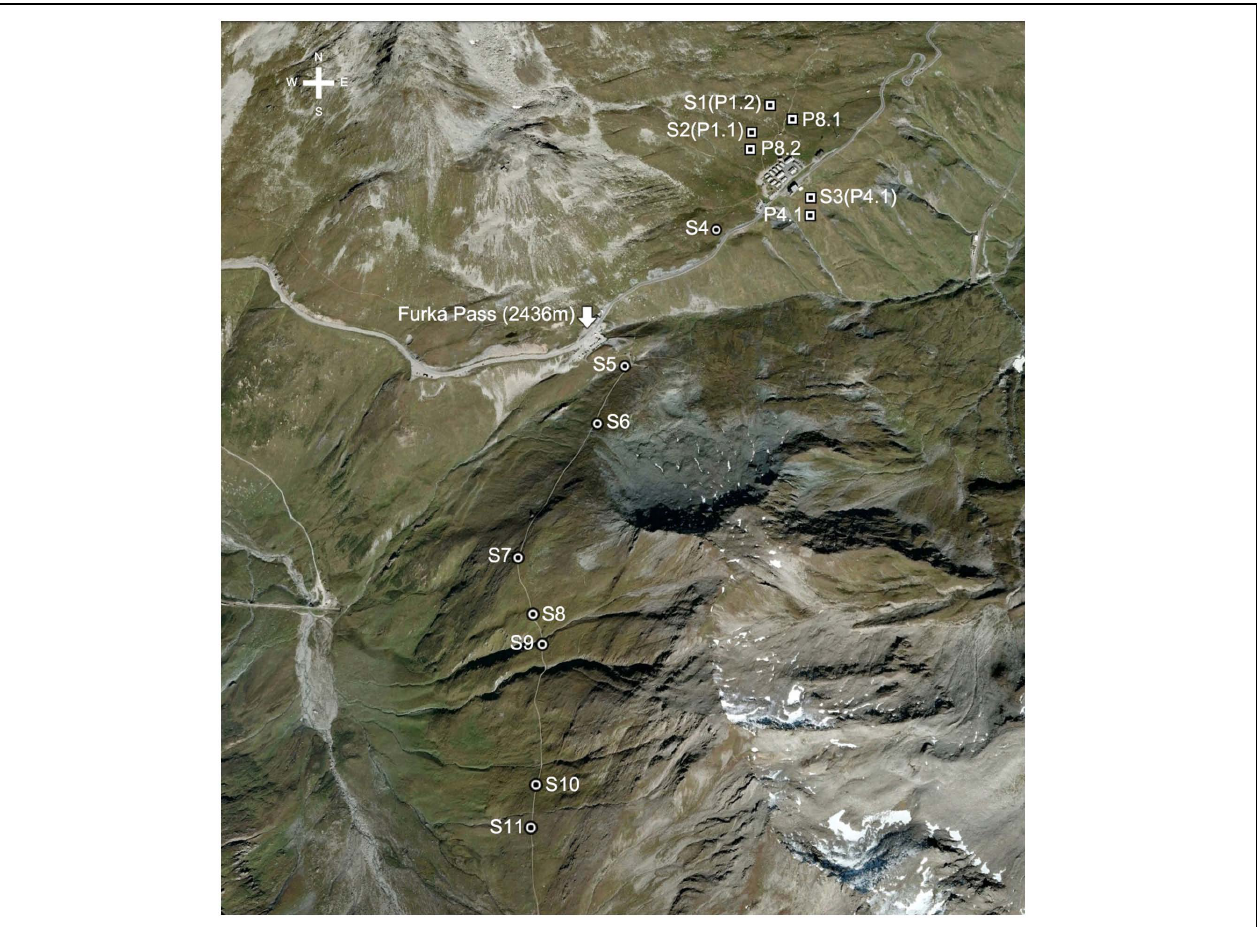
FIGURE 1 | Location of sampling sites (S, circles) near Furka Pass, Swiss Central Alps at 2430–2500 m and six permanent plots (P, squares) near the ALPFOR research station [adapted from Google Earth (version 7.1.2.2041)].